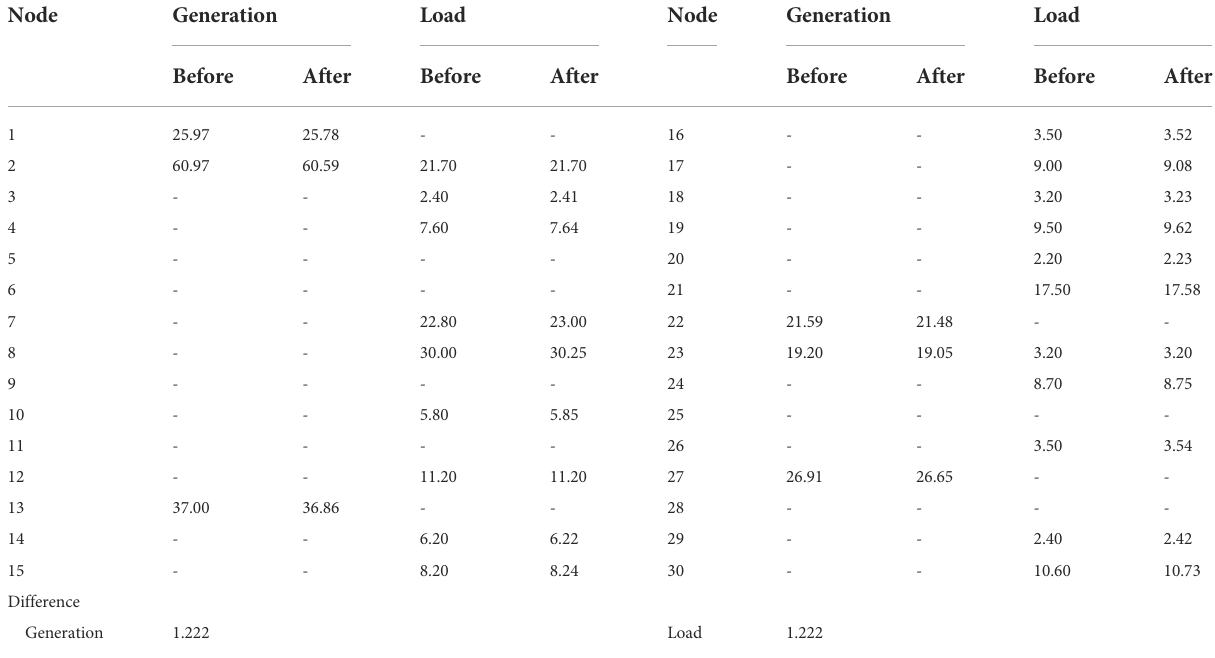
TABLE 7 The comparison of active power output and active load data. Node